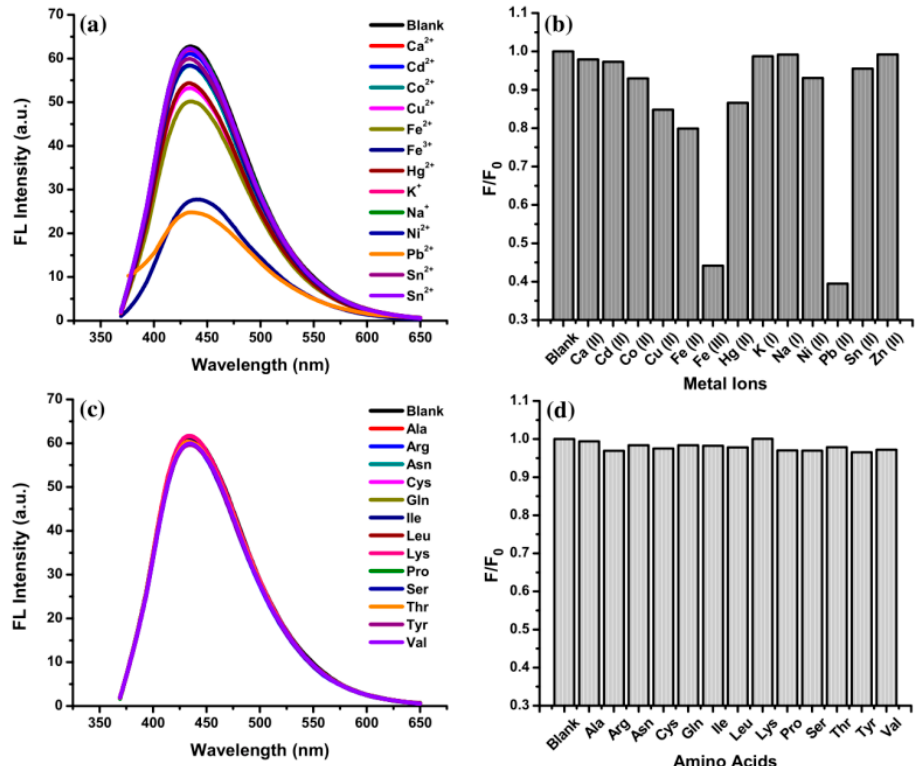
Figure 5. The FL quenching efficiency of VV-CDs solution after adding ( a , b ) various metal ions and ( c , d ) amino acids at a concentration of 1000 µ M excited at 360 nm.